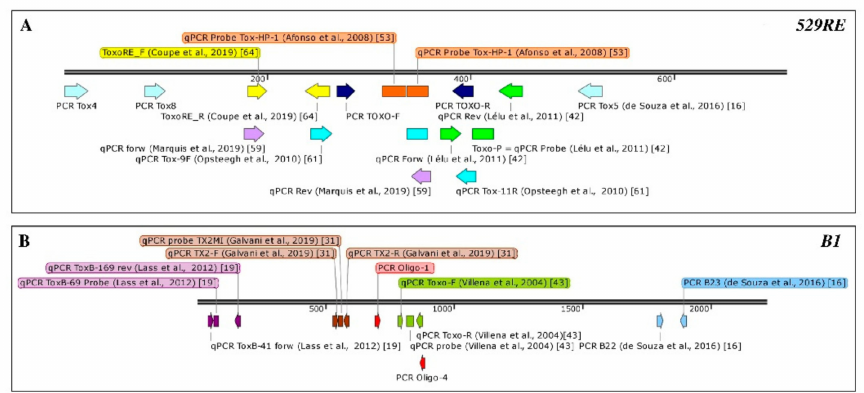
Figure 2. Graphical representation (using Snap Gene Viewer 5.0.7 software, GSL Biotech LLC, US) and localisation of primers and probes reported in Tables 4 and 6 and used in cPCR and qPCR assays to target: ( A ) the 529 RE (Accession number FJ656209.1) and ( B ) the B1 genes (Accession number